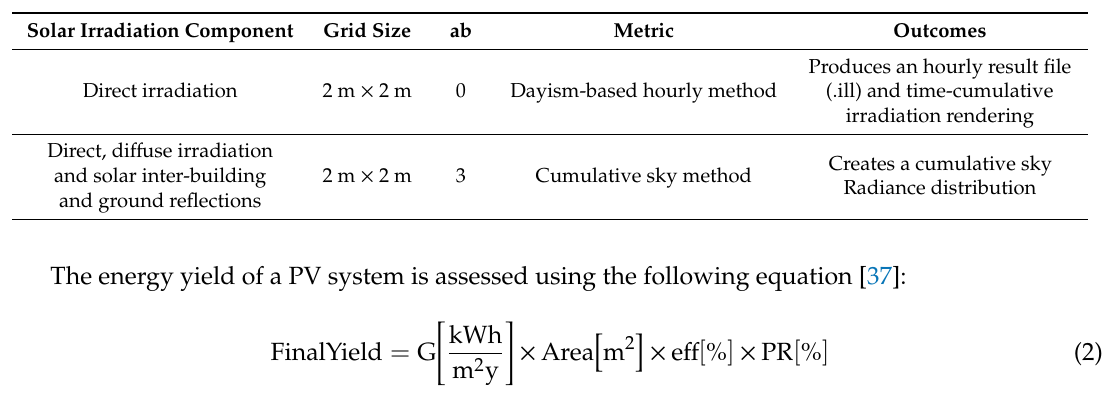
Table 10. Parameters used for grid-based irradiation